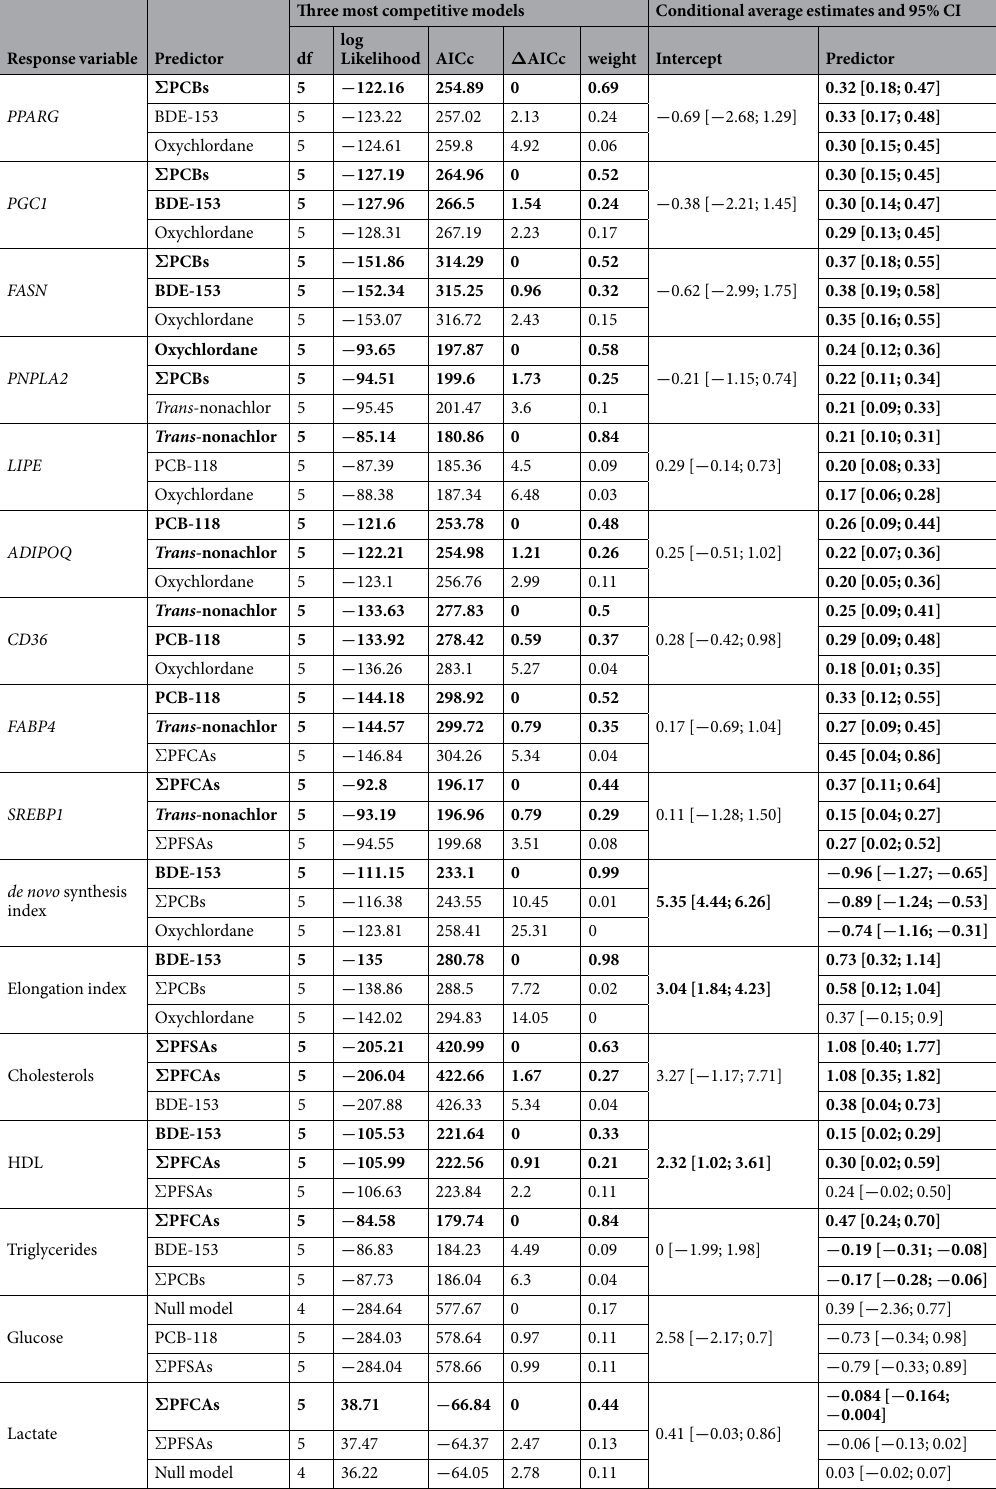
Table 1. Relationships between biomarkers of energy metabolism and pollutant concentrations in female polar bears adipose tissue and plasma captured in Svalbard (2012–2013). The three most competitive models including the best predictor ( Δ AICc = 0), predictors that received strong support ( Δ AICc ≤ 2), conditional averaged estimates and 95% confidence intervals derived from mixed models are given. Bold values represent significant relationships, shaded rows represent the variables and relationships with Δ AICc <